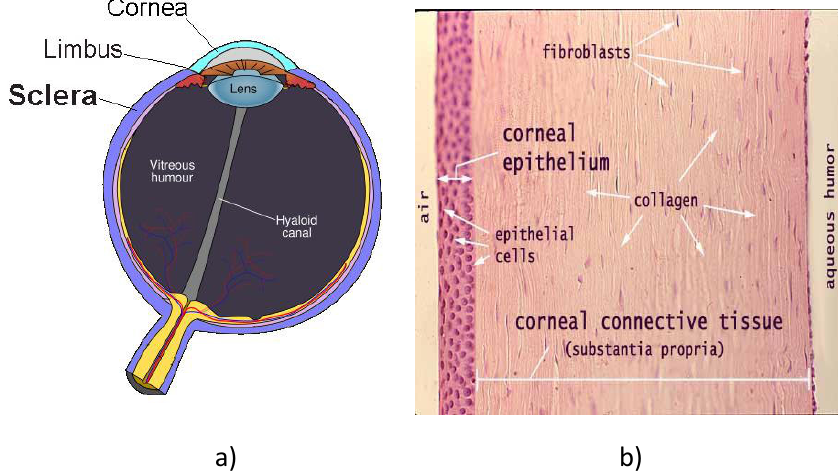
Figure 5. a) Schematic illustration of a cross-section of an eye showing the various regions on the surface of the eye that are mentioned in the text [56]. b) Histology section of the cornea